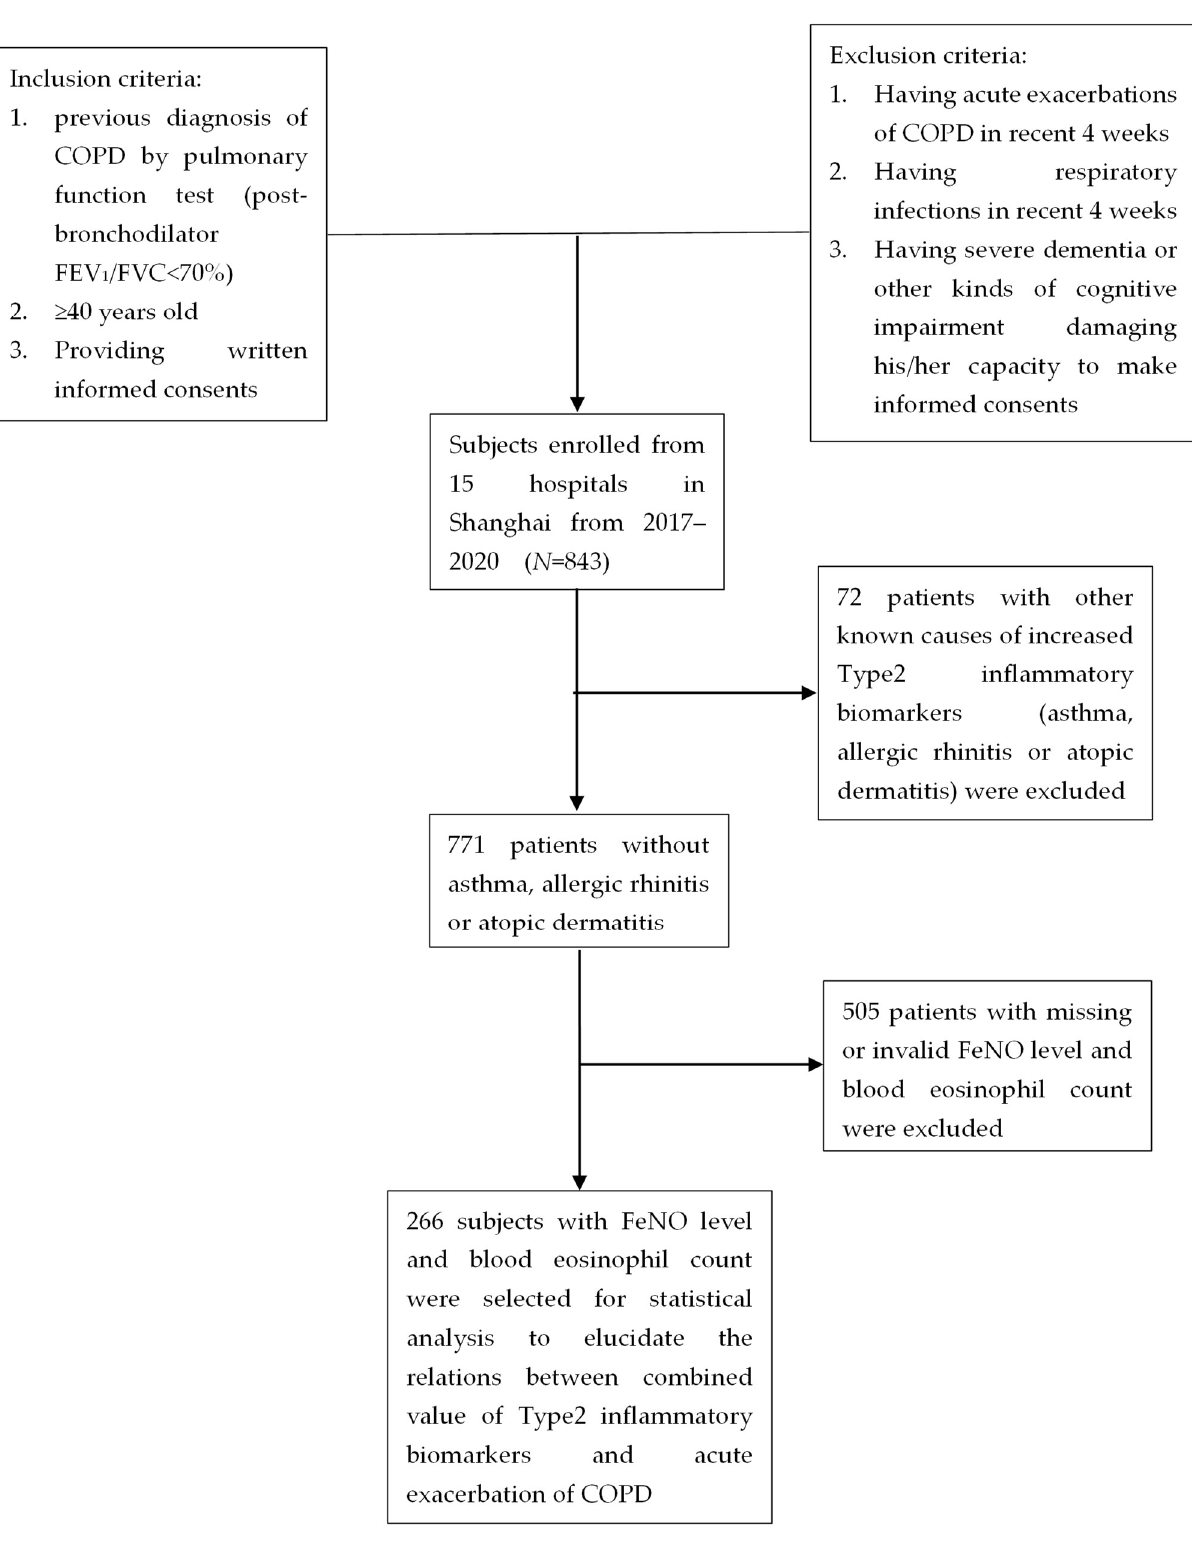
Figure 1. Consort diagram of the